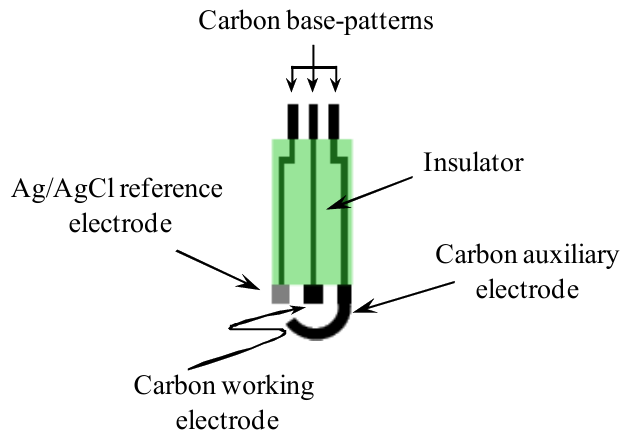
Figure 3. Diagram of the three-electrodes screen-printed configuration used in the fabrication of the